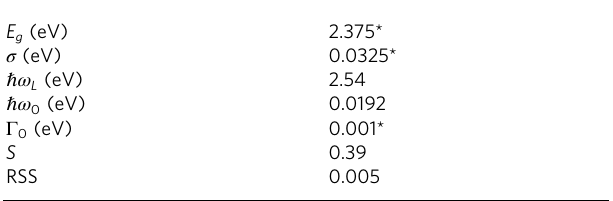
Values marked with an asterisk represent estimates based on experimental evidence from this work( E g , σ ),orpreviousreports( Γ 0 ).RSSistheresidualsumofsquaresobtainedwiththegiven